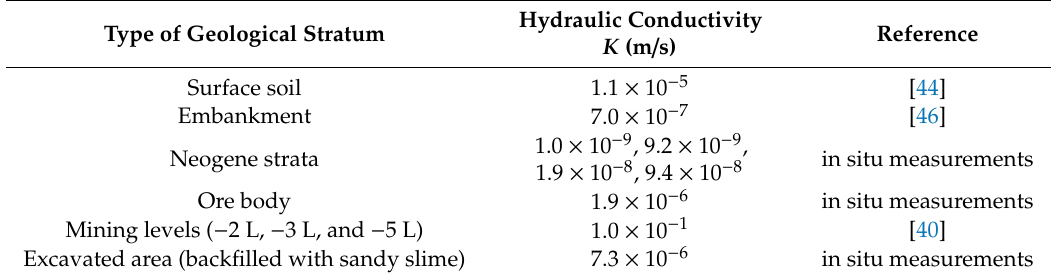
Table 2. Hydraulic conductivities of different geological strata.